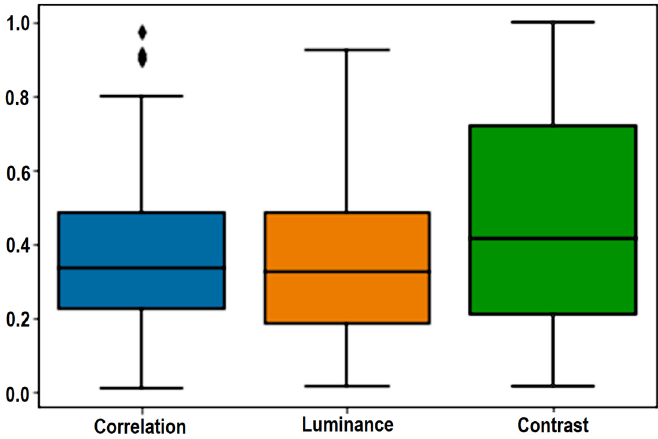
Figure 2. UQI evaluation score plot of kinfaceW dataset.